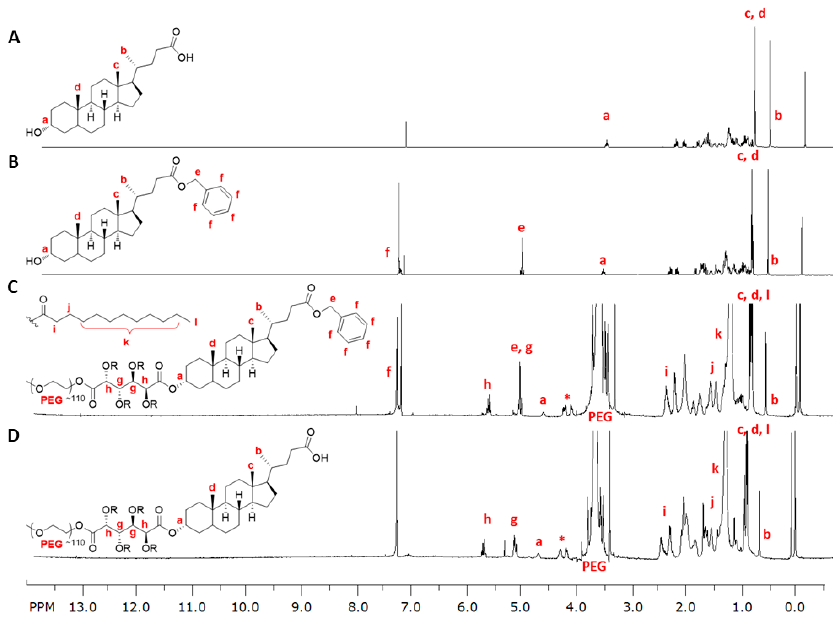
Figure 2. Sequential 1 H-nuclear magnetic resonance (NMR) spectra in the synthesis of 1cMLCA. ( A ) LCA; ( B ) benzyl lithocholate; ( C ) 1cM benzyl lithocholate; ( D ) 1cMLCA. (*) represents methylene group in PEG adjacent to the ester.